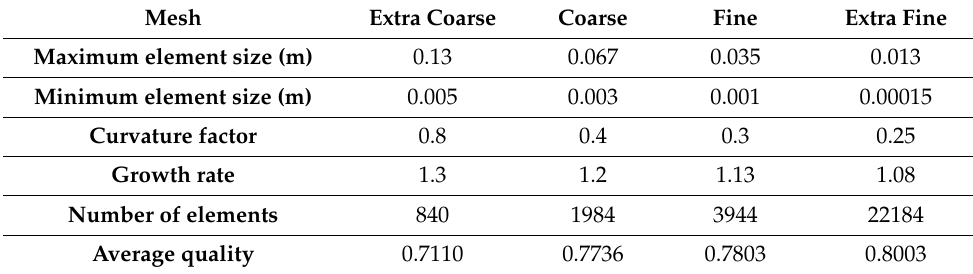
Table 2. Mesh-quality parameters.